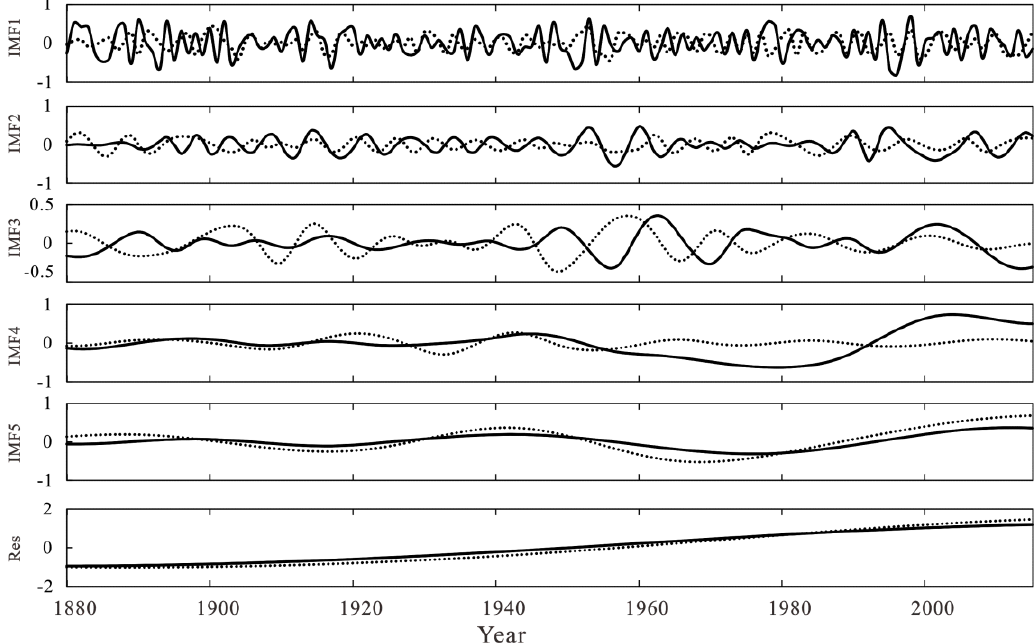
Figure 4. EMD of the temperature anomaly in Shanghai and globally (Solid line represents Shanghai, and dotted line represents global temperatures).